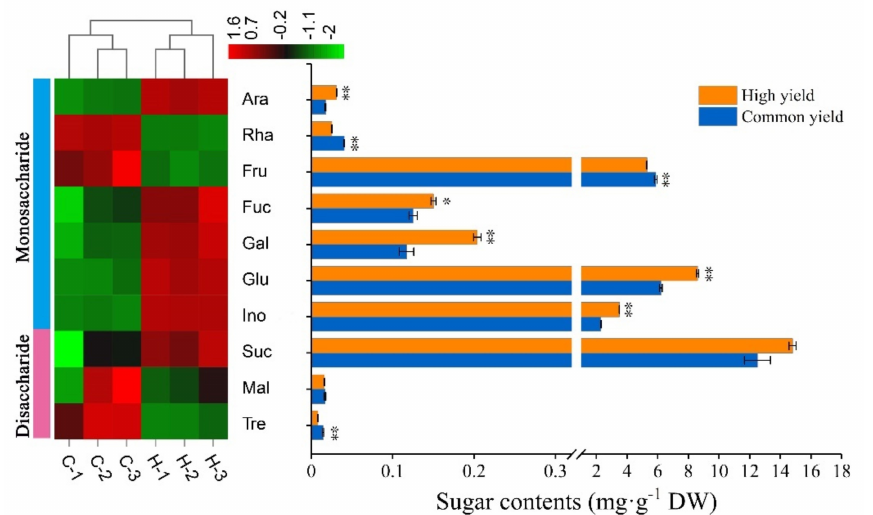
Figure 2. Sugar contents of masson pine needles in the high and common resin yield. DW means dry weight. “Common yield” means the common resin-yielding clone, and “High yield” means the high resin-yielding clone. Error bars refer to the standard deviation (SD) of three biological repeats. * and ** indicate significant differences between the high and common ones at p < 0.05 and p < 0.01, respectively. C-1, C-2, and C-3 represent three biological repeats of common ones, H-1, H-2, and H-3 represent three biological repeats of a high one. The color brightness represents the degree of the content difference, as shown in the color bar. Ara, D-arabinose; Rha, L-rhamnose; Fru, D-fructose; Fuc, L-fucose; Gal, D-galactose; Glu, glucose; Ino, inositol; Suc, sucrose; Mal, maltose; Tre,